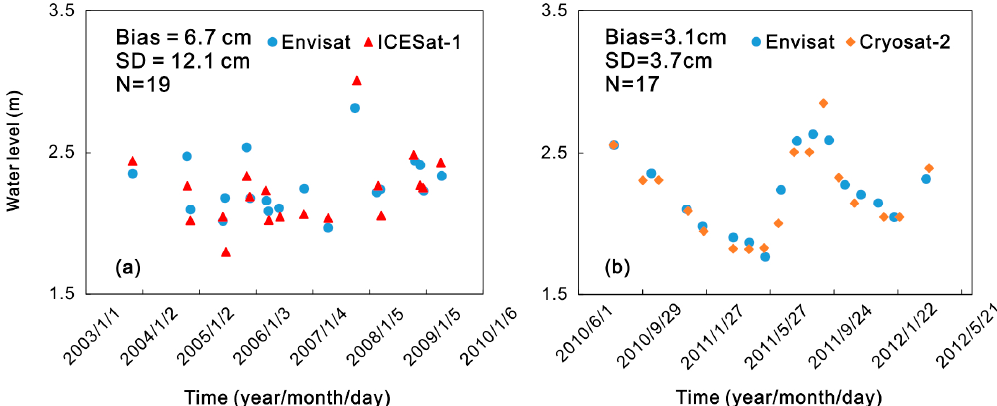
Figure 4. The scatter plots of paired satellite observations between ( a ) Envisat and ICESat-1, and ( b ) Evnisat and Cryosat-2 over the Tai Lake, with estimated biases and Standard Deviations (SD). N is the number of observations. Remote Sens. 2020 , 12 , x FOR PEER REVIEW